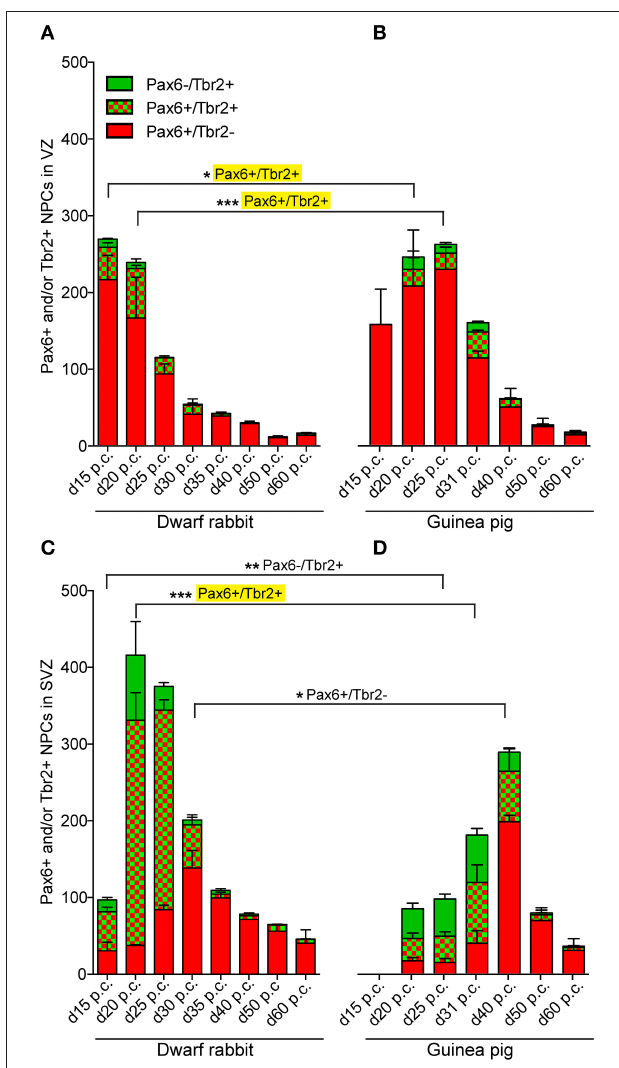
FIGURE 3 | Quantification of Pax6 + /Tbr2–, Pax6 + /Tbr2 + , and Pax6–/Tbr2 + NPCs in the VZ and SVZ of the developing guinea pig and dwarf rabbit neocortex. (A–D) Pax6 + /Tbr2– (red), Pax6 + /Tbr2 + (red/green), and Pax6–/Tbr2 + (green) NPCs in the VZ (A,B) and SVZ (C,D) of day 15 to 60 post-conception (p.c.) dwarf rabbit (A,C) and guinea pig (B,D) neocortex, expressed as number of cells per 100 µ m ventricular surface. Y-axis for (B) is shown in (A) , y-axis for (D) is shown in (C) . Color legend is shown in (A) . For dwarf rabbits, the cortical wall corresponding to a total ventricular surface of 4.56–8.26 µ m was analyzed. Data represent mean ± SD and are from two (d30 p.c., d35 p.c., d40 p.c., d50 p.c., d60 p.c.) or three (d15 p.c., d20 p.c., d25 p.c.) brains each. The cortical wall corresponding to a total ventricular surface of 2.70–13.68 µ m was analyzed for the guinea pig. Data represent mean ± SD and are from two (d15 p.c., d20 p.c., d25 p.c.) or three (d31 p.c., d40 p.c., d50 p.c., d60 p.c.) brains each. Asterisks indicate statistically significant differences in Pax6 + /Tbr2 + NPCs, Pax6 + /Tbr2–, and Pax6–/Tbr2 + NPCs between corresponding neurogenesis stages of the dwarf rabbit and guinea pig, *** p < 0.001; ** p < 0.01; * p < 0.05. Corresponding cortical neurogenesis stages were determined according to Workman et al. (2013) (www.translatingtime.org). For details, see the Materials and Methods section. Cell counts on a yellow background are significantly higher in the dwarf rabbit when compared with the guinea